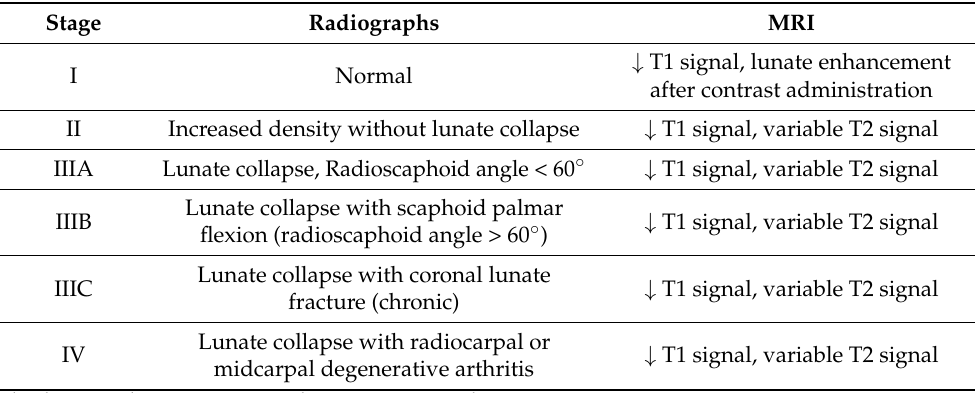
Table 1. Lichtman’s